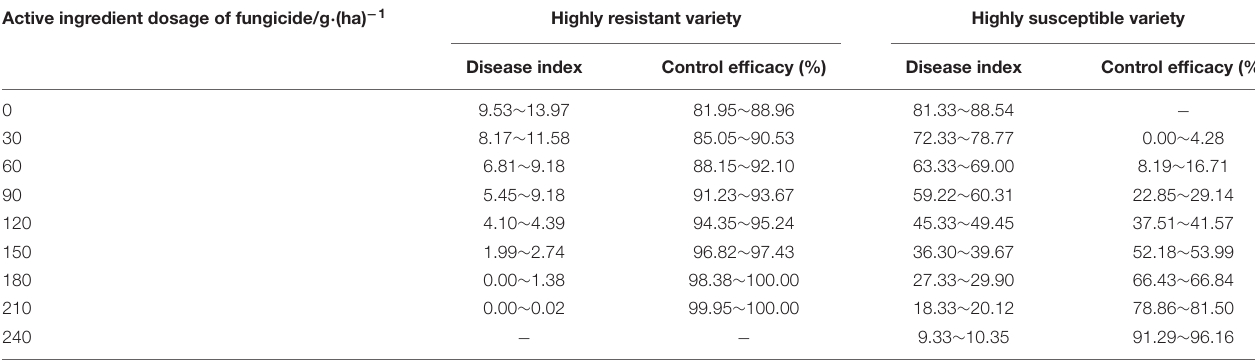
TABLE 10 | Reference table for the active ingredient dosages of enostroburin · epoxiconazole 18% SC to wheat powdery mildew on different resistant varieties. Active ingredient dosage of fungicide/g · (ha) − 1